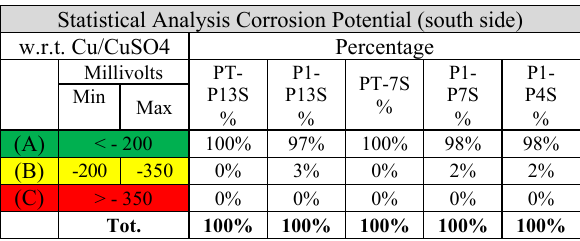
Table 1 . Statistical analysis of the corrosion potential. (A) Probability of 90% of absence of corrosion activity, (B) Uncertain, (C) Probability of 90% of presence of corrosion activity.